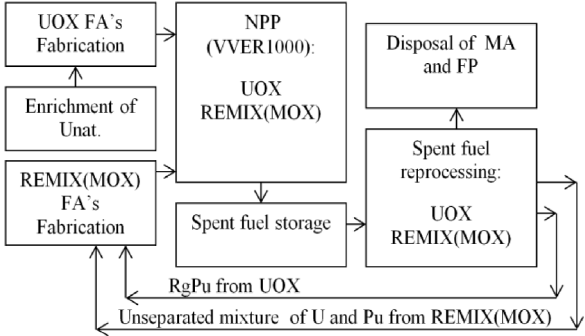
Fig. 4. The fl owchart with REMIX(MOX)-fuel.